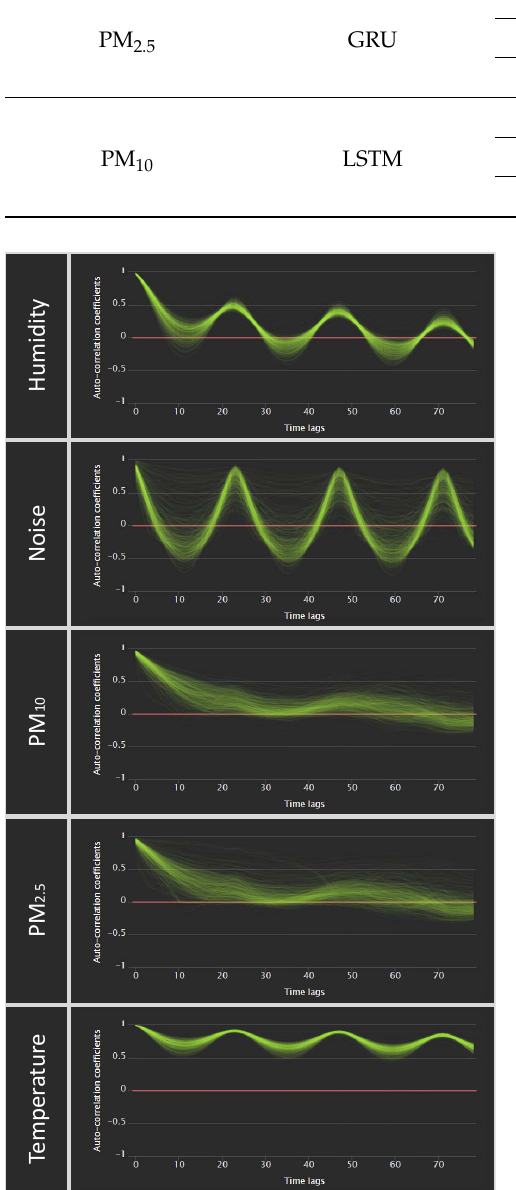
Figure 2. The temporal autocorrelations of all variables are visualized over time lags. Humidity, noise, and temperature tend to have high autocorrelations every 24 h. However, PM 2.5 and PM 10 do not have repeated temporal